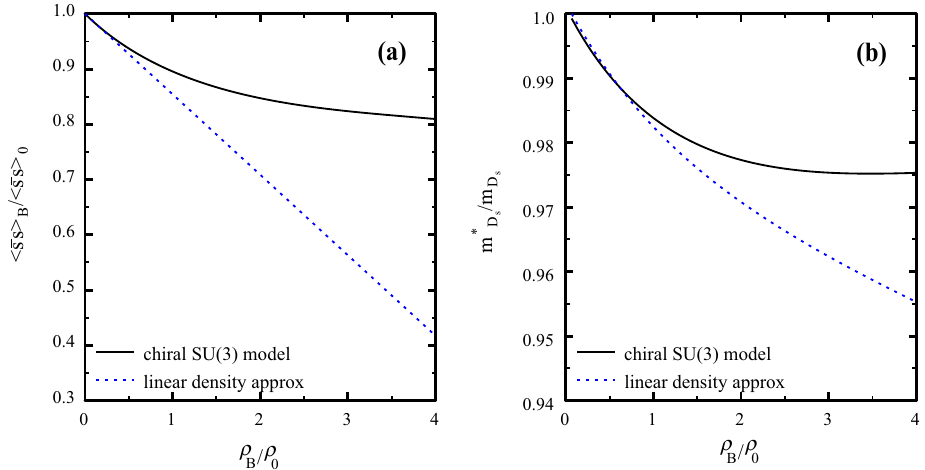
Fig. 4 We represent the variation of strange quark condensates (subplot a ) and mass of the D s ( 1968 ) meson (subplot b ), as a function of baryonic density, calculated in the linear density approximate QCD sum rules and compared with chiral SU(3) model, in cold symmetric nuclear